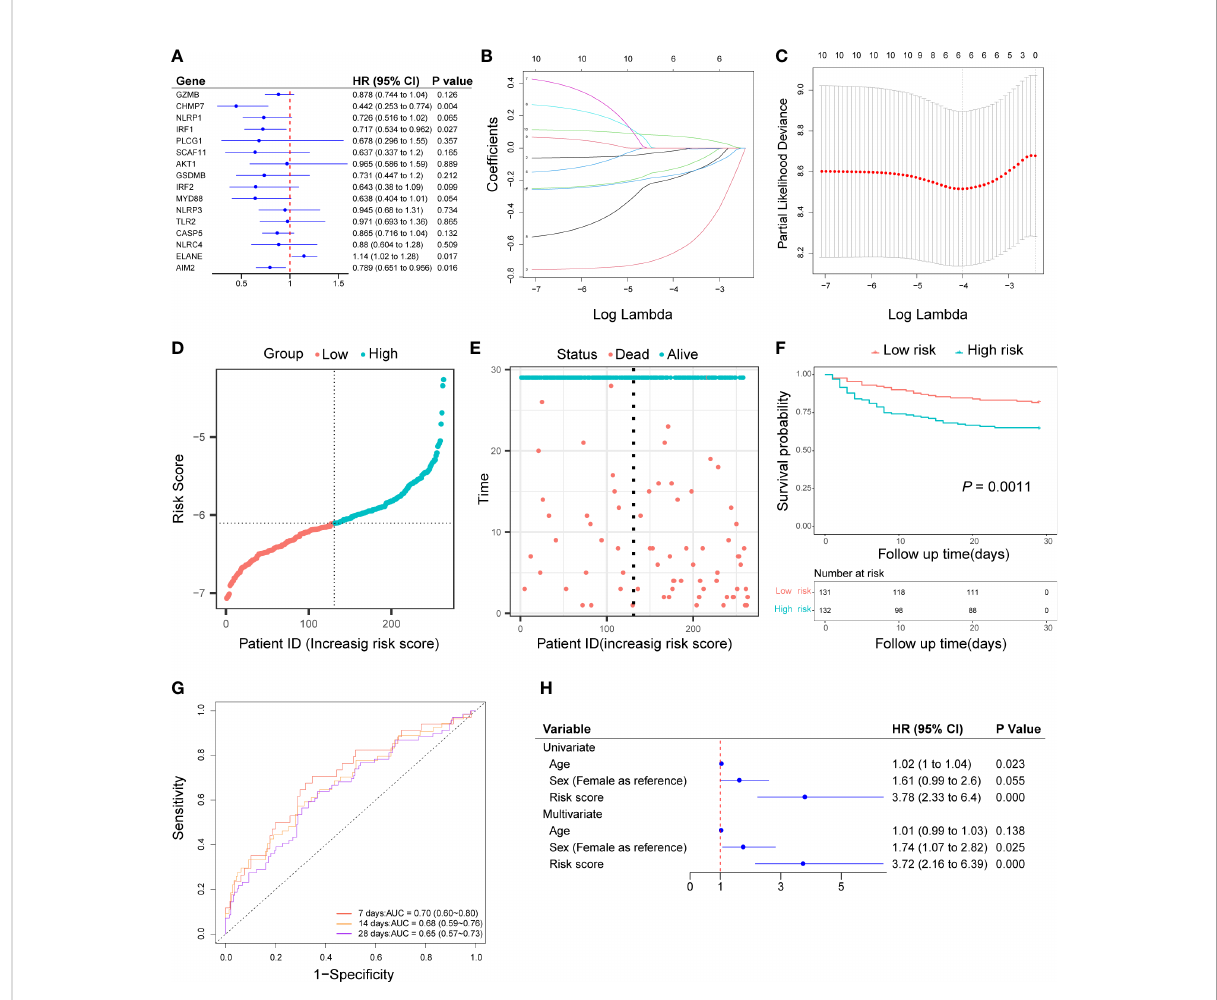
FIGURE 3 Construction of pyroptosis-related prognostic risk score and prediction of the prognosis in the discovery cohort. (A) Univariate cox regression analysis of survival for 16 pyroptosis-related DEGs, and 10 genes with a P < 0.2. (B) LASSO-Cox regression of the 10 candidate genes. (C) Cross- validation for tuning predictor selection. (D) Distribution of patients based on the risk score. (E) Survival time and status of patients. (F) Kaplan- Meier curves analysis for the survival of patients in low- and high-risk groups. (G) Time-dependent receiver operating characteristic curve for 7-, 14-, and 28-day survival of sepsis patients. (H) Univariate and multivariate cox